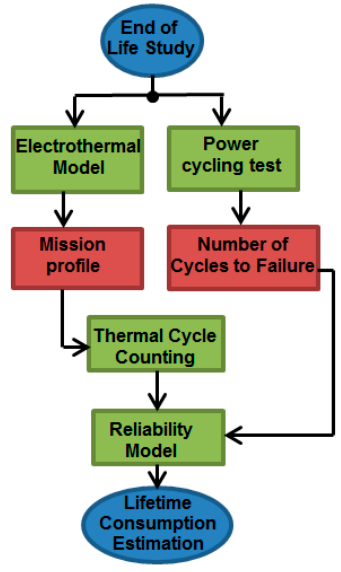
Figure 17. Schematic of a lifetime consumption study.